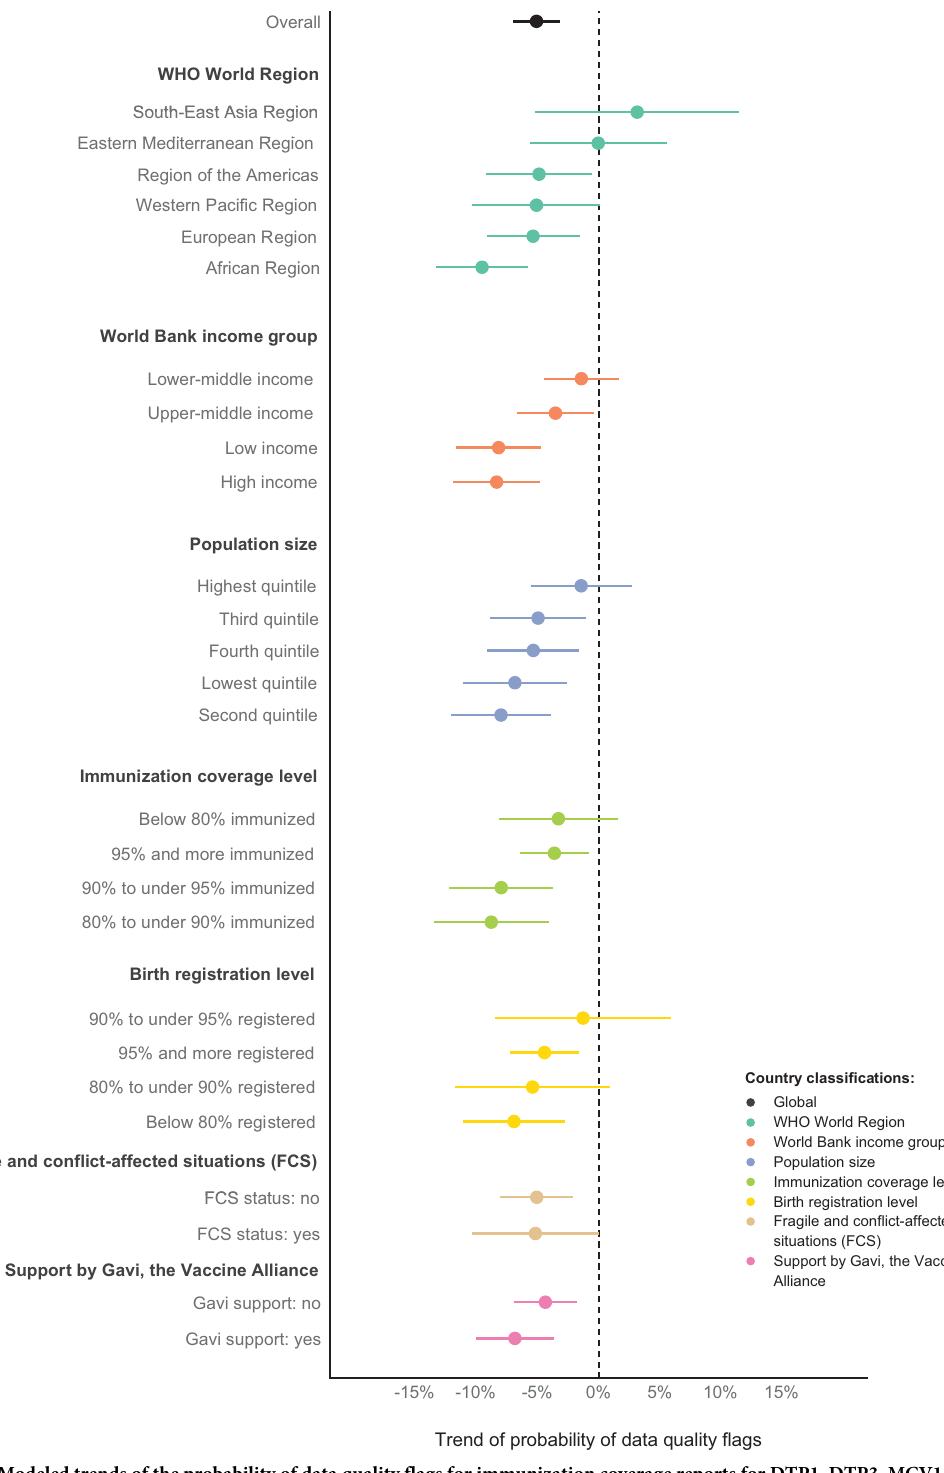
Fig 3. Modeled trends of the probability of data quality flags for immunization coverage reports for DTP1, DTP3, MCV1, and BCG, by different country classifications, 194 WHO Member States, 2000–2019. Notes: Colored lines represent 95% confidence intervals (CI). Country data as reported by 15 July 2020. BCG = Bacillus Calmette-Gue´rin vaccine birth